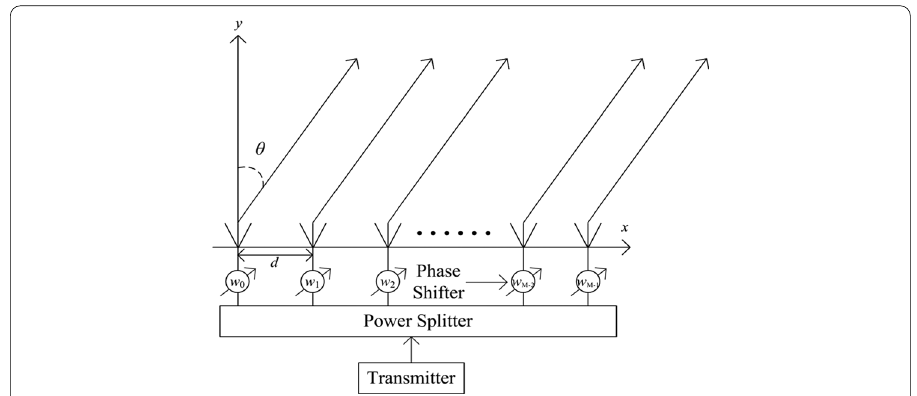
Fig. 1 Uniform linear phased array with M